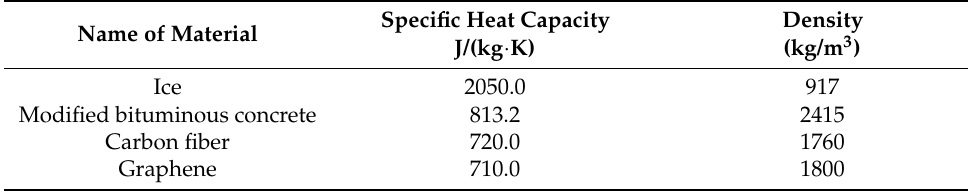
Table 18. Electrothermal parameters of some materials related to the test.